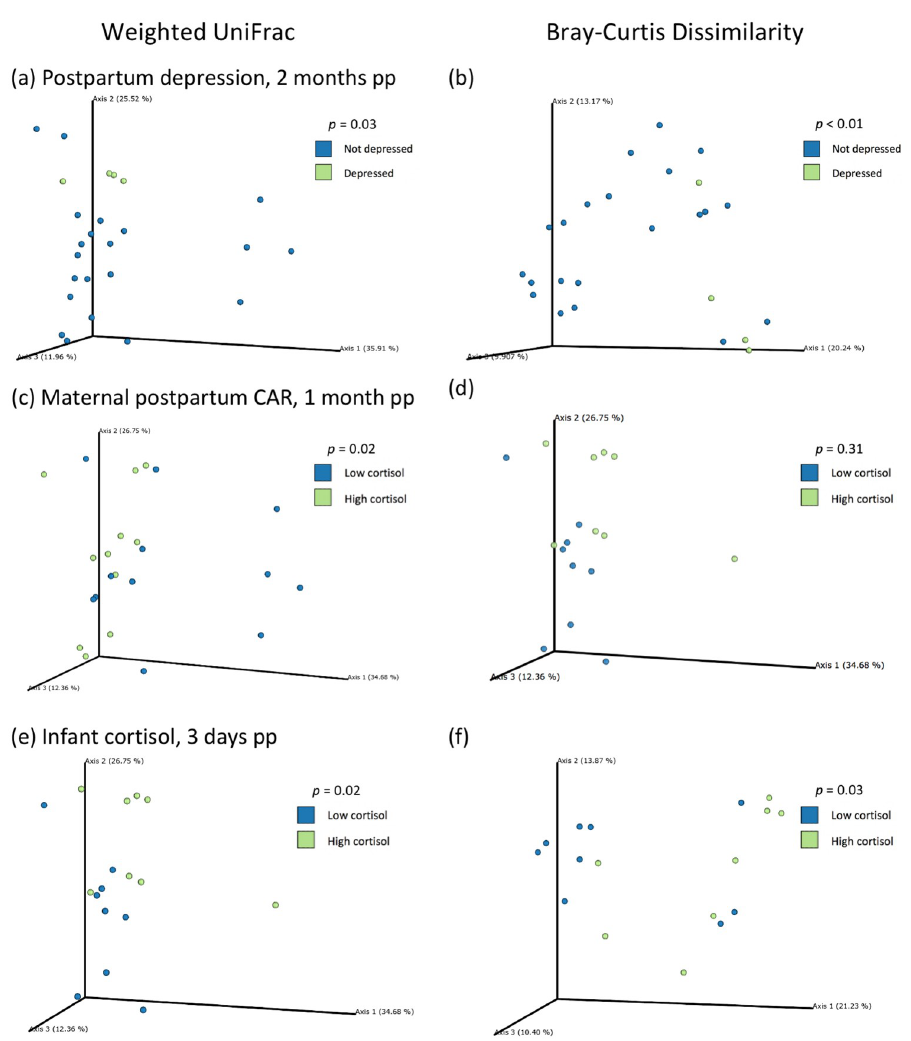
Fig 3. Stool sample sequences from infants cluster separately by maternal postpartum depression, maternal postpartum cortisol awakening response, and infant cortisol on a Principal Coordinates Analysis (PCoA) using weighted UniFrac distances and Bray-Curtis